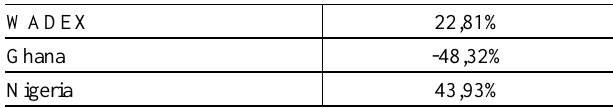
Table 4: West Africa: Historical returns for 2000